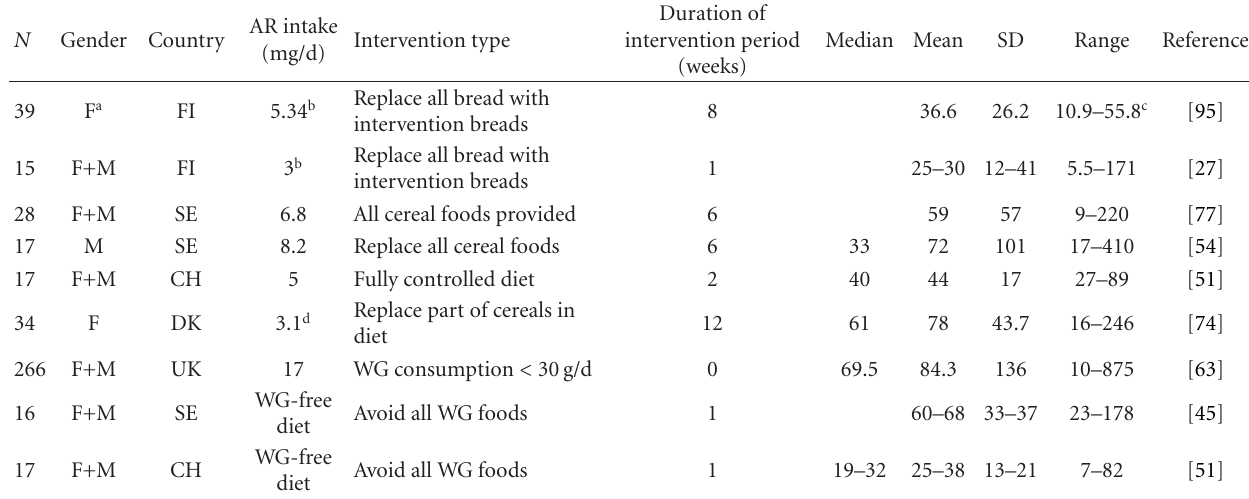
Table 4: Plasma AR concentrations when subjects have consumed low or essentially AR-free diets.